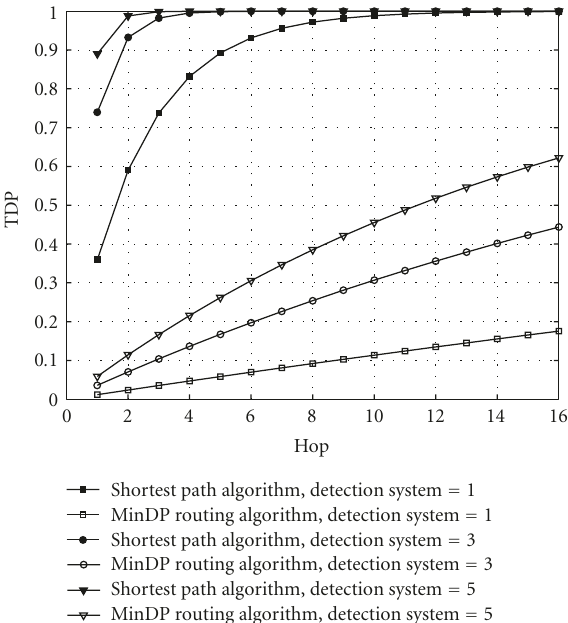
Figure 9: Total detection probability function of